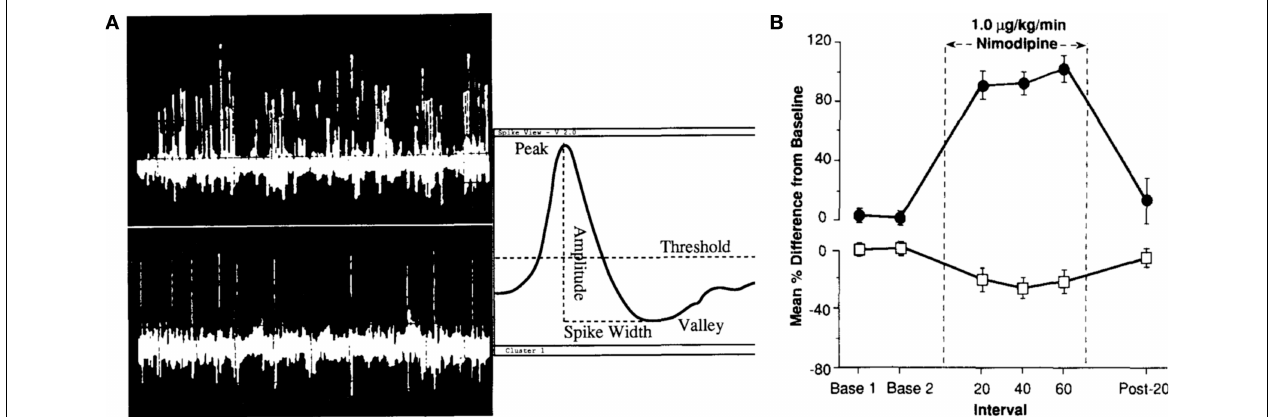
FIGURE 2 | Baseline in vivo fi ring rate of CA1 pyramidal neurons is signifi cantly enhanced with L-type calcium channel blocker nimodipine. (A) Single-unit discrimination (fi ring neurons) using the spike separation algorithms is illustrated. The top left trace shows 1 s of a typical multi-unit signal recorded midway through stratum pyramidale of fi eld CAl in the dorsal hippocampus with clear theta frequency (4–8 Hz) modulation of the fi ring of many cells. The lower left trace shows 5 s of a classic “single-unit” signal (pyramidal neuron) recorded in the